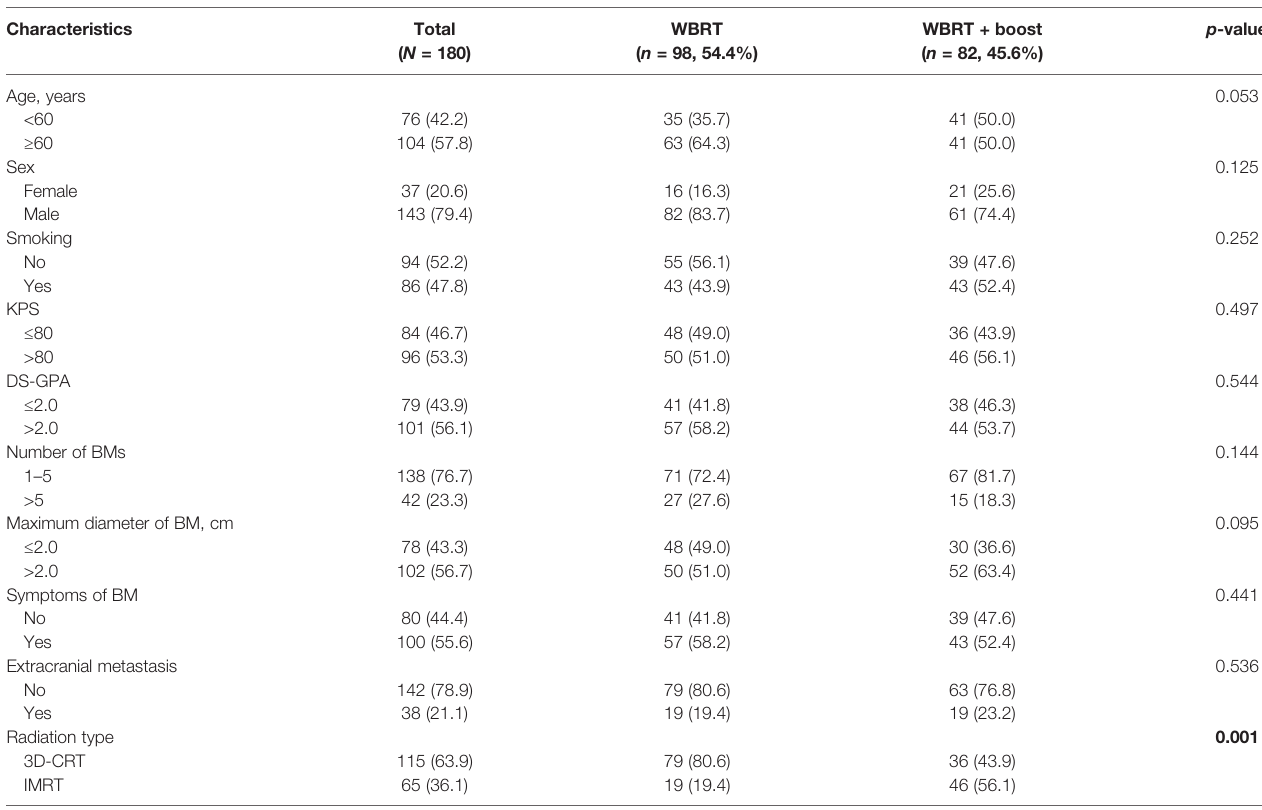
TABLE 1 | Baseline characteristics of 180 SCLC patients with BM.